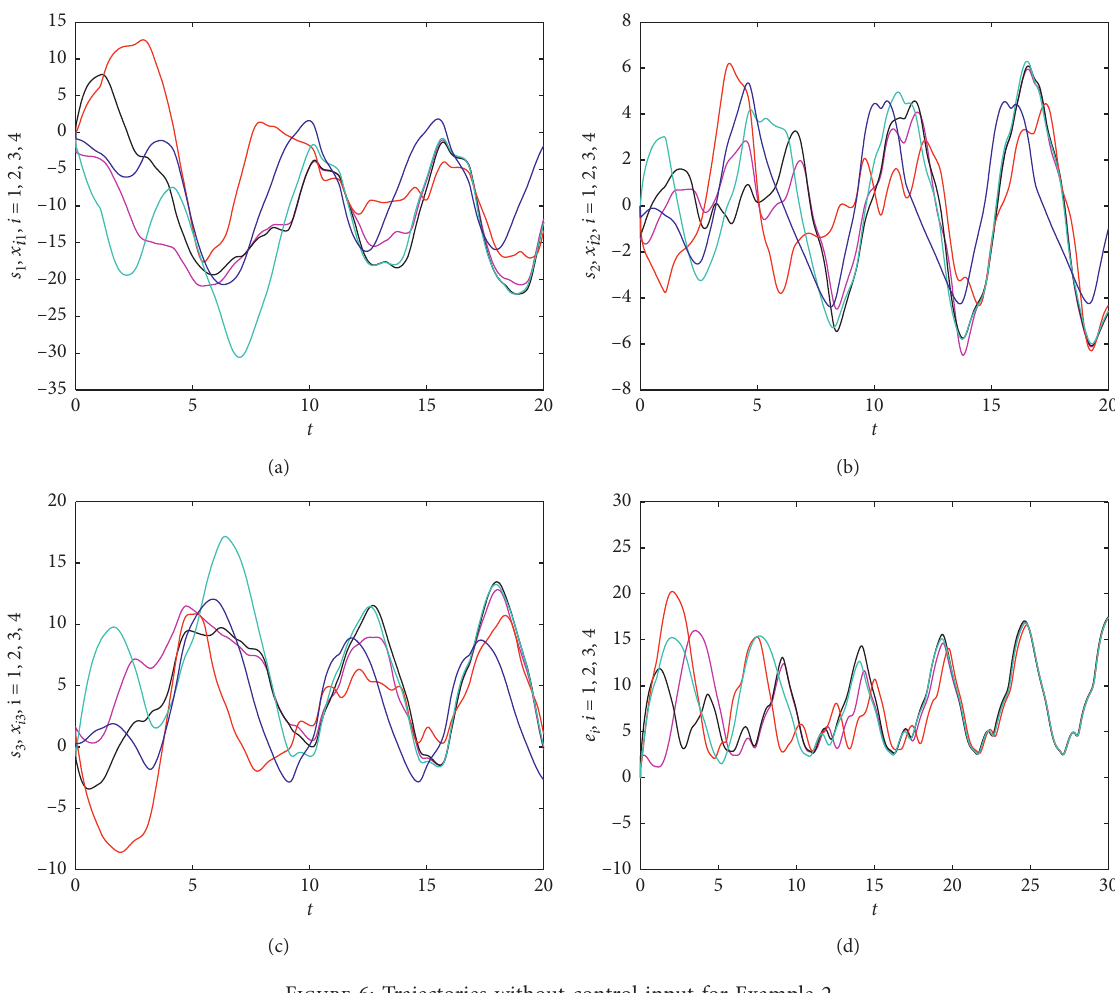
Figure 6: Trajectories without control input for Example